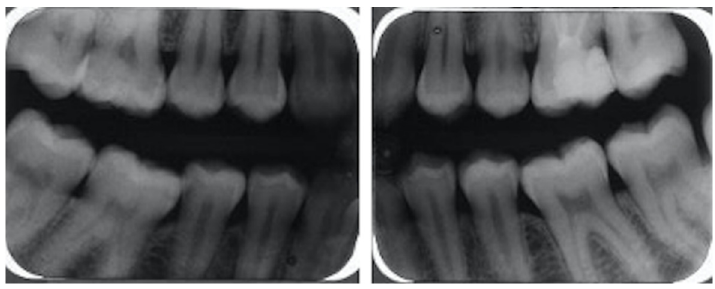
Figure 2. Radiological investigation of the mother demonstrating no bone loss. The proband’s two siblings (sister +3, brother 4 years) and the mother’s sister [III:3] did not display any signs of EDS. The maternal grandfather [II:2], 59 years old, was reported to